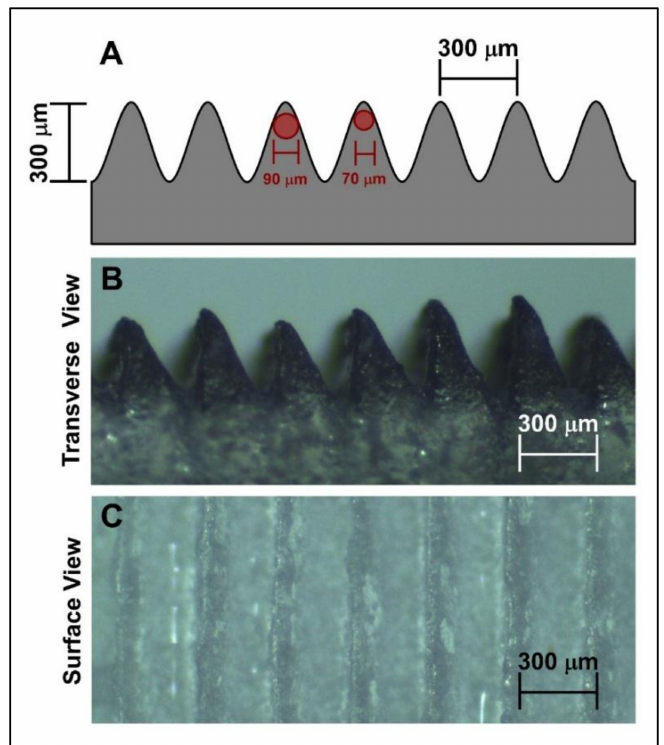
Figure 1. Design of the microstructured mold. ( A ) Schematic representation of the mold (red: theoretical fiber sizes). ( B ) Image of the acrylic mold using stereoscopic microscope (transverse view). ( C ) Image of the acrylic mold using stereoscopic microscope (surface